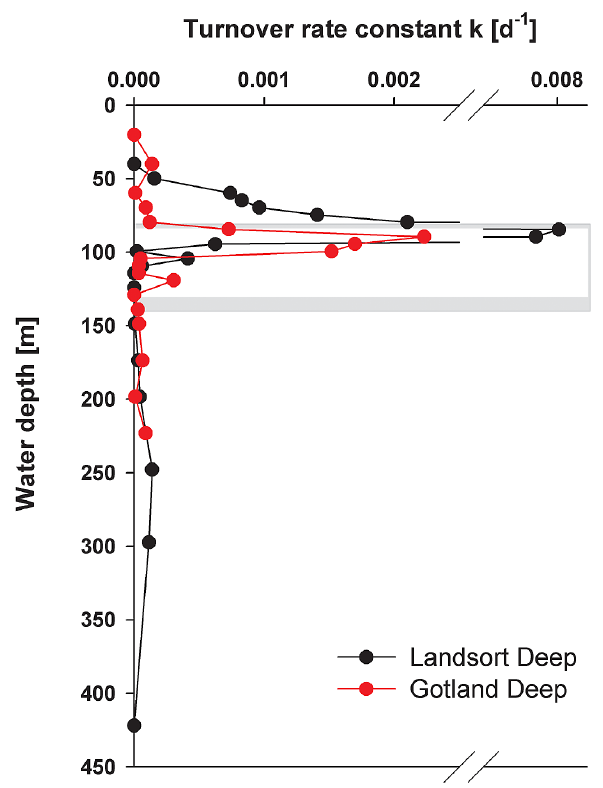
Fig. 4. Turnover rate constants ( k) from the Gotland Deep (red) and Landsort Deep (black). Indicated are the redox zones of the Gotland Deep (gray-shaded area) and the Landsort Deep (white